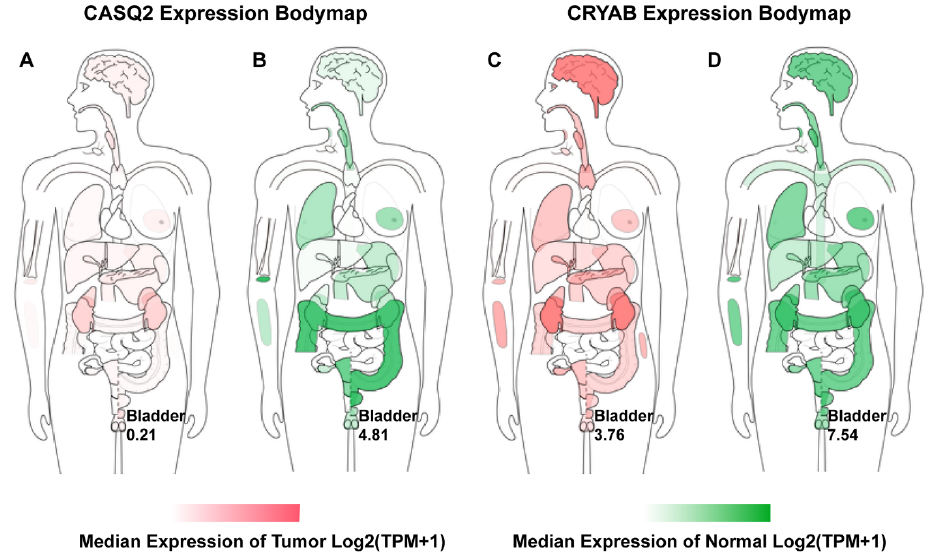
Figure 8. The median expression of CASQ2 and CRYAB in tumors (red) and normal tissues (green) in a body map. Deeper color represents higher expression levels. The map is based on the GEPIA database ( http://gepia.cancer-pku.cn ). TPM = transcripts per million.